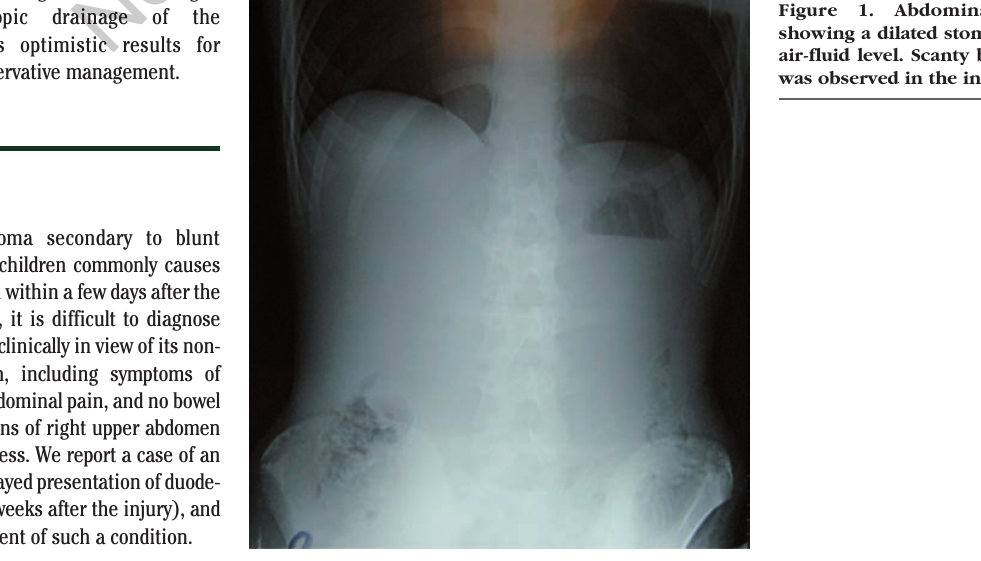
Figure 1. Abdominal X-ray showing a dilated stomach with air-fluid level. Scanty bowel gas was observed in the